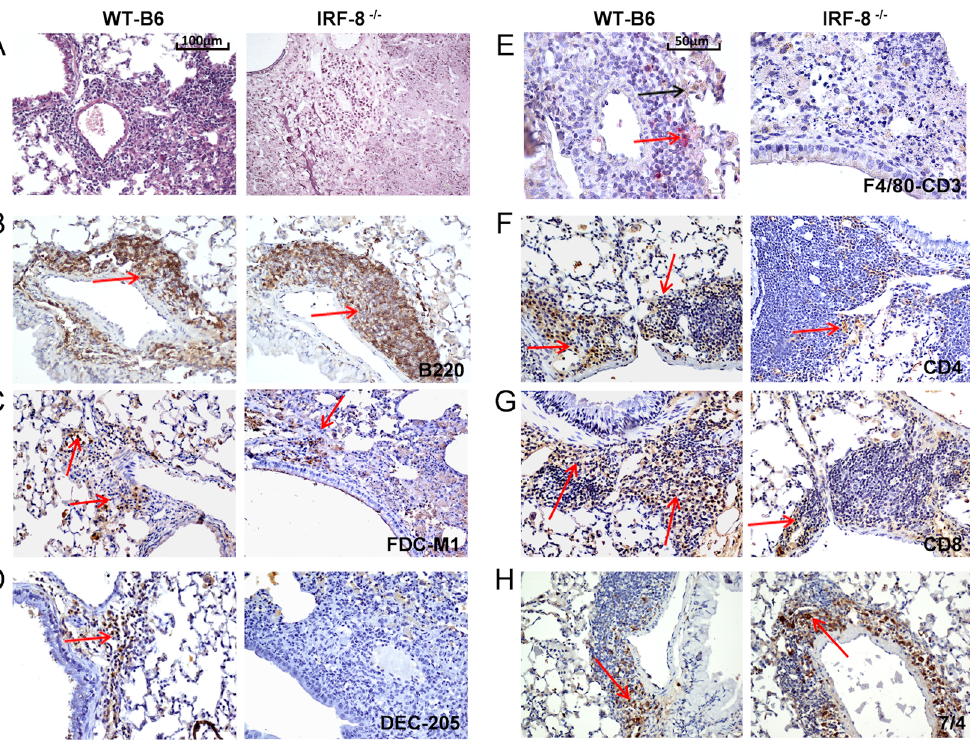
Figure 6. Loss of LS organization in lungs of Mtb -infected IRF-8 2 / 2 . IHC analysis of pulmonary sections from Mtb -infected mice at day 30 p.i. showing the distribution of immune cells in perivascular, peribronchial and interstitial areas of lung tissues. A) H&E staining (200X). B–D and F–H) Staining with the indicated mAbs (brown). Red arrows depict marker-positive cells. E) Co-staining with anti-F4/80 (brown) and anti-CD3 (red) mAbs, depicted by black and red arrows respectively. Representative slides are shown all taken at 200X magnification, except for (B) taken at 400X magnification. Three independent experiments were performed.